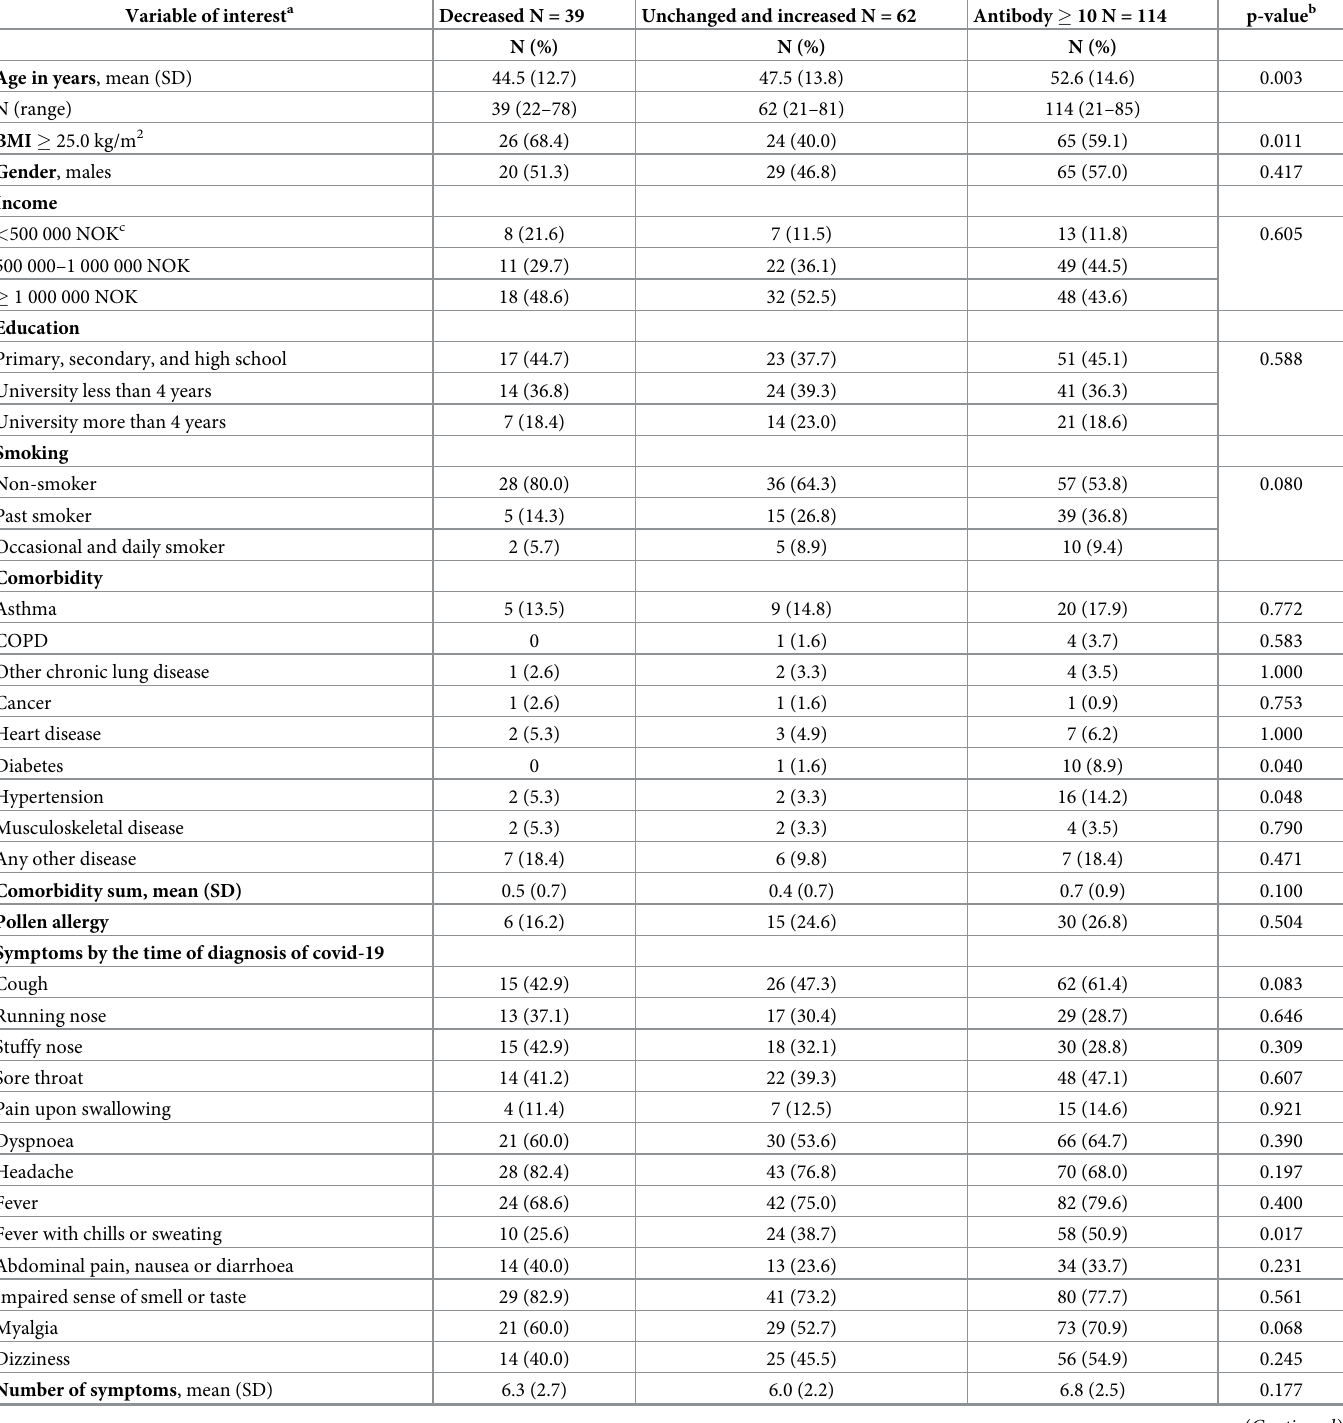
Table 3. The distribution of variables in PCR+ participants with detectable antibodies grouped as decreased, unchanged, increased, and antibody level � 10 at time point T1 and T2. Variable of interest